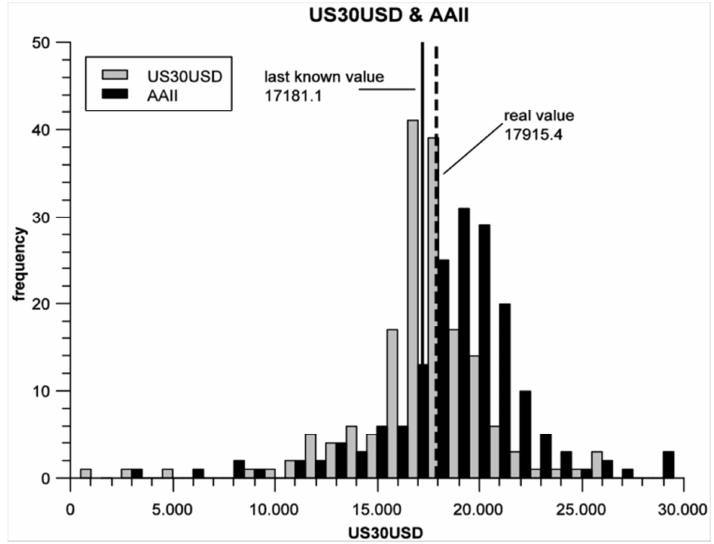
Figure 8. Combination of the US30USD index and individual investors’ sentiment (AAII) distributions